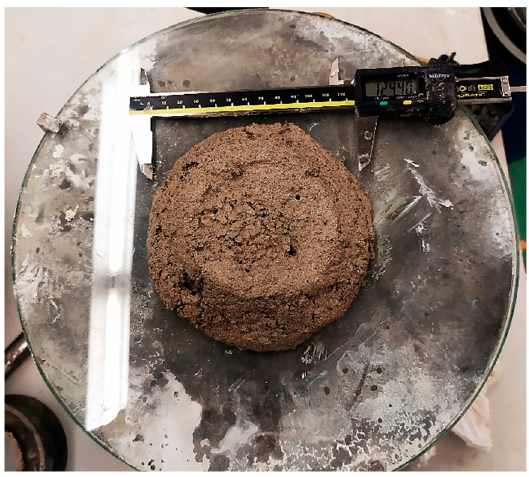
Figure 3. Image of a lime mortar representative slump obtained in agreement with EN 1015-3. Table 2. Sample codes of the lime mortars prepared with w/b = 0.61 and relative fibrillated cellulose and superplasticiser (SP) dosage ( w / w ) per weight of binder.